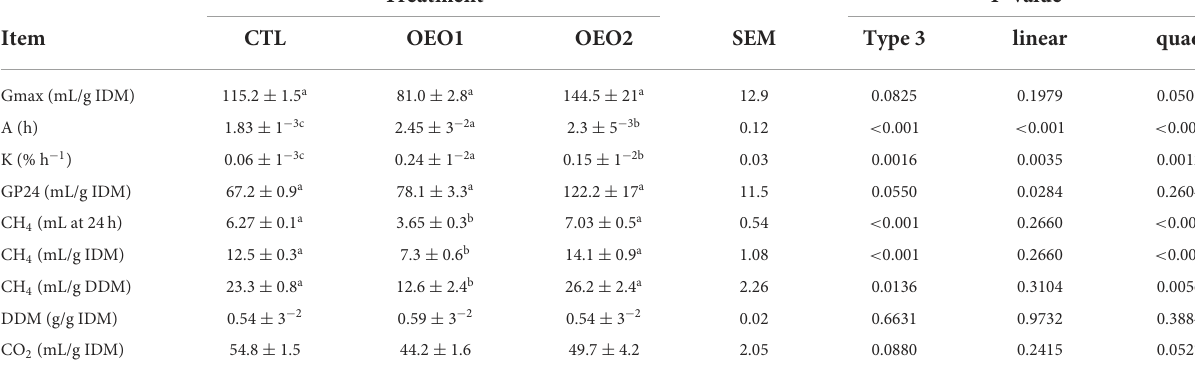
TABLE 4 Maximum in vitro gas production, lag phase, constant gas production rate, and in vitro CH 4 production in response to supplementation with orange essential oil (OEO; n = 6). Treatment P